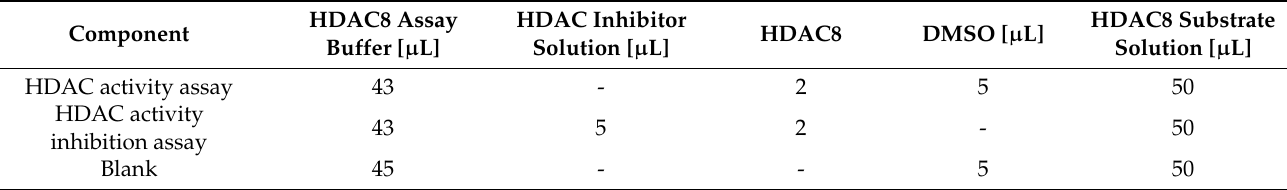
Table 7. Reaction scheme for HDAC8